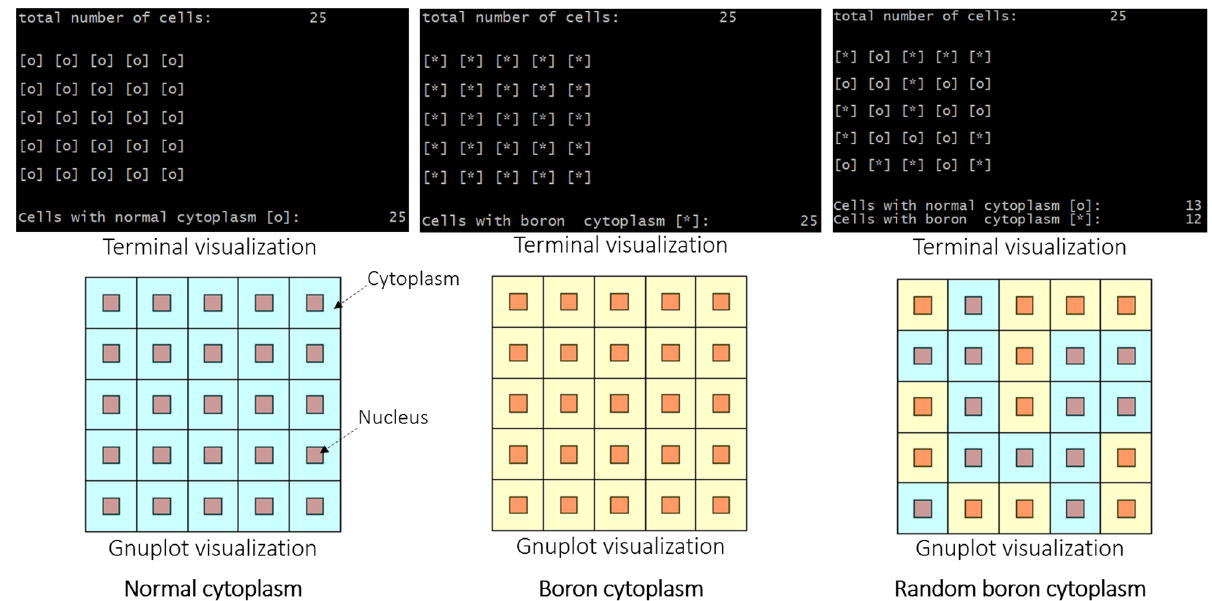
Figure 3. Normal, boron filled, and random boron filled cytoplasm in the modelled cell array visualized by terminal and gnuplot visualization tools embedded in our program (blue represents normal and yellow represents boron filled cytoplasm).